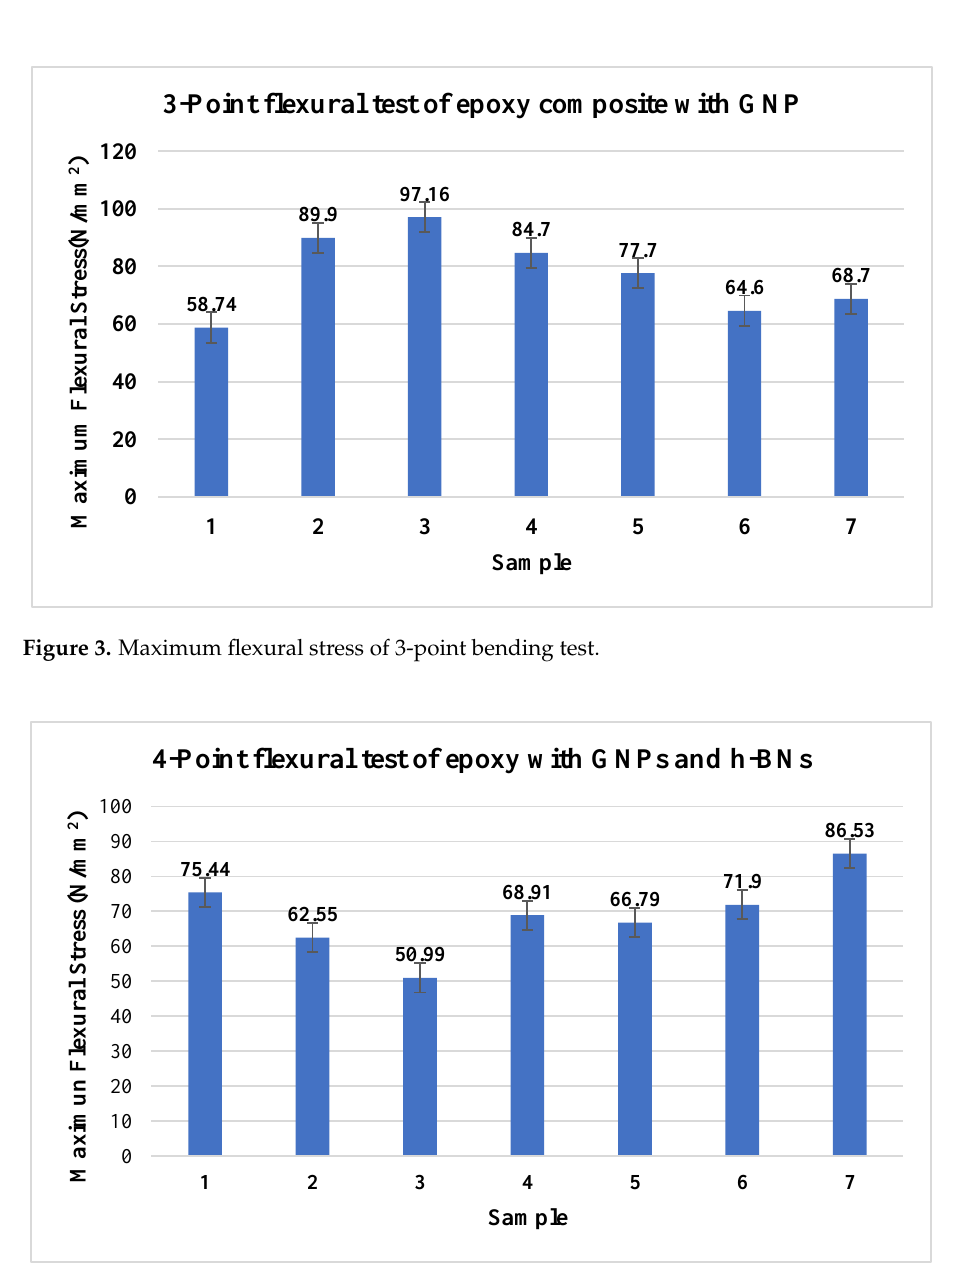
Figure 4. Maximum flexural stress of 4-point bending test.